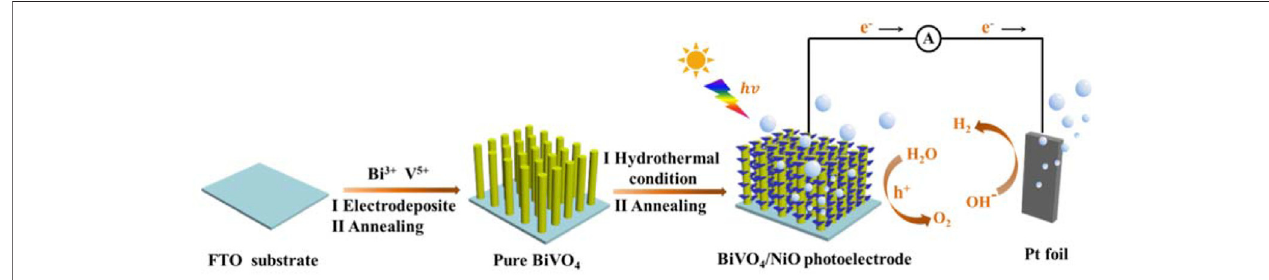
FIGURE 8 | Schematic illustration of the fabrication process of BiVO photoanode system.